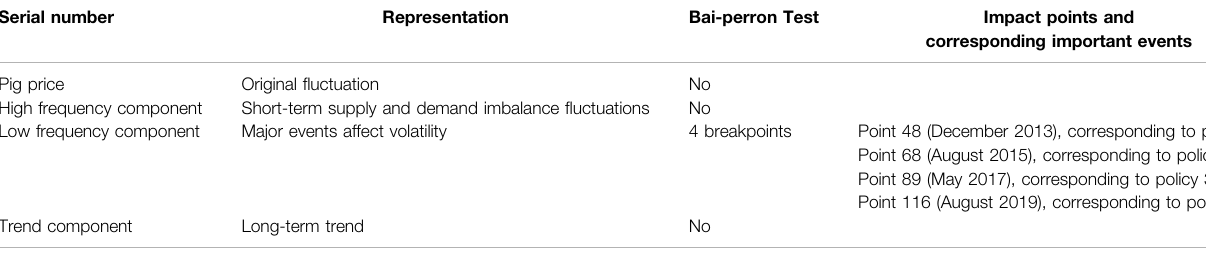
TABLE 6 | Test results of the impact of important regulatory policies on hog ’ s price fl uctuations.